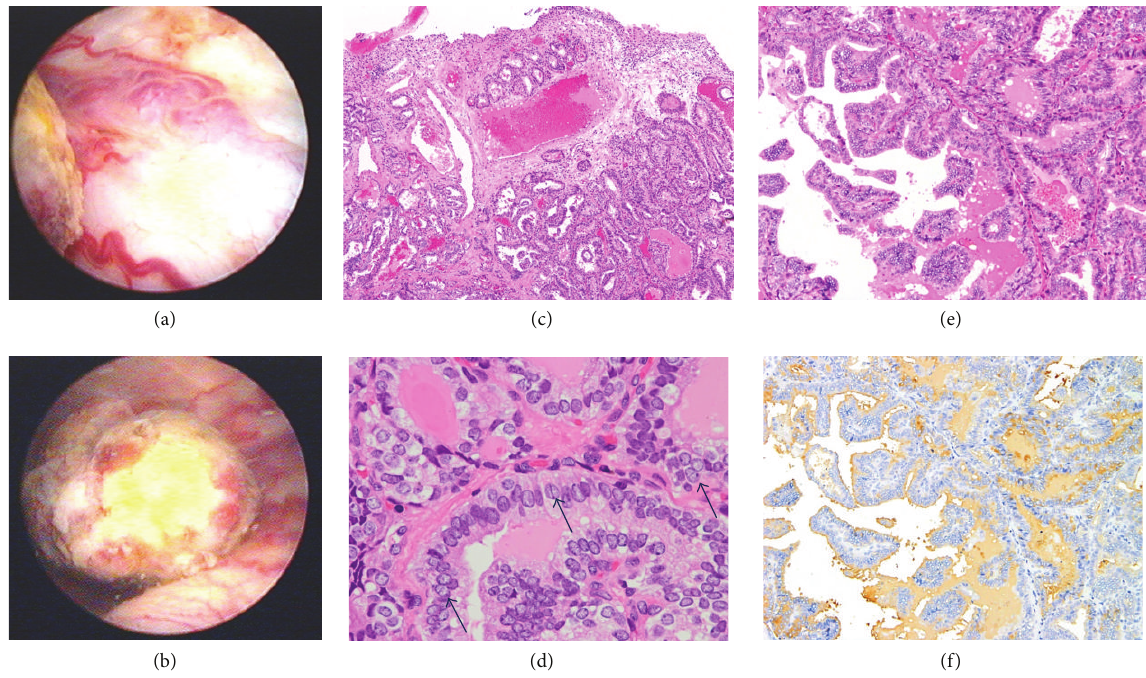
Figure 1: Metastatic bladder tumor of thyroid papillary carcinoma. Cystoscopy findings of the bladder tumor ((a) and (b)). It should be noted that meandering blood vessels are associated with the tumor (a). Part of the tumor was covered with a white coating (b). Pathological findings of the bladder tumor ((c) to (f)). A proliferation of atypical cells forming a papillary structure and colloid formation below the transitional epithelial cells, H&E, × 40 (c). Proliferating cells with ground-glass nuclei and nuclear groove, indicated by arrows, H&E, × 400 (d). H&E staining (e) and immunostaining with antithyroglobulin antibodies (f) of an almost identical portion of the tumor ×